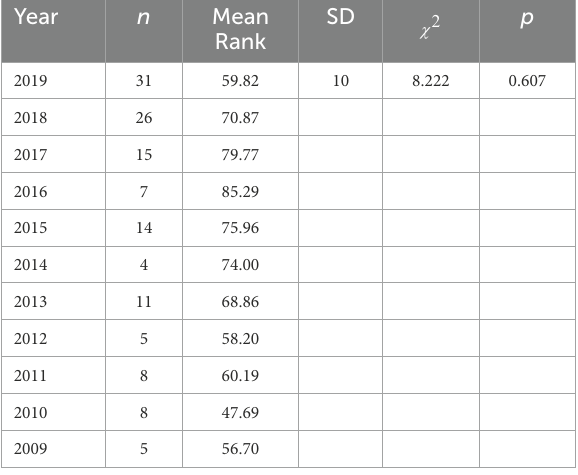
TABLE 3 H-Test results of similarity indexes of postgraduate theses in Turkey grouped by